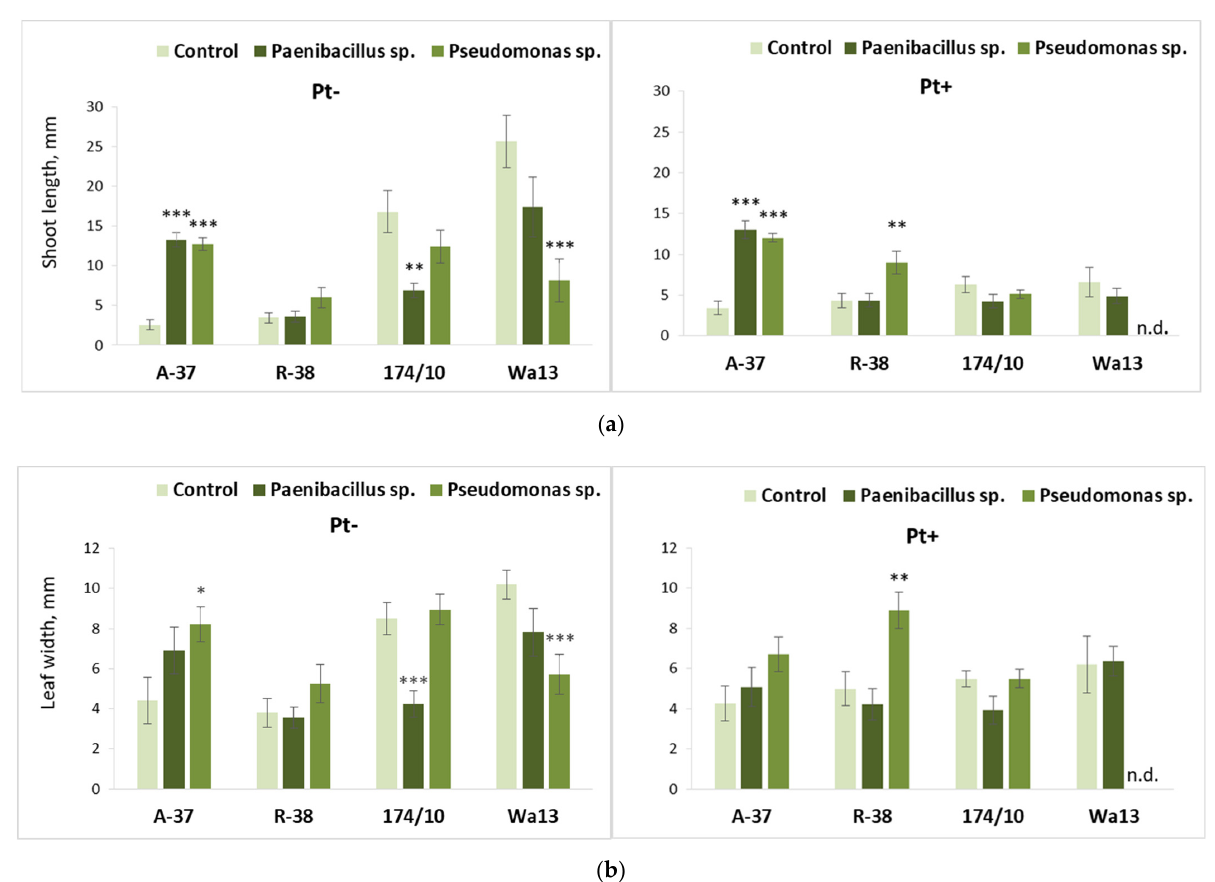
Figure 7. Average shoot length ( a ) and leaf width ( b ) of different Populus genotypes (A-37 and R-38, P. tremula ; 174/10 and Wa13, P. tremula × P. tremuloides ), whose explants were first cultured on the nutrient medium inoculated with Paenibacillus sp. or Pseudomonas sp. bacteria, then transferred onto fresh nutrient medium, either sterile (‘Pt − ’) or inoculated with fungus Phellinus tremulae (‘Pt+’). Statistically significant differences from the control variant, which was not treated with bacteria during the first culture stage, are indicated (for each genotype separately): * p < 0.05; ** p < 0.01; *** p < 0.001. ‘N.d.’ means that, because of decreased explant viability, no reliable data were obtained for a particular variant.